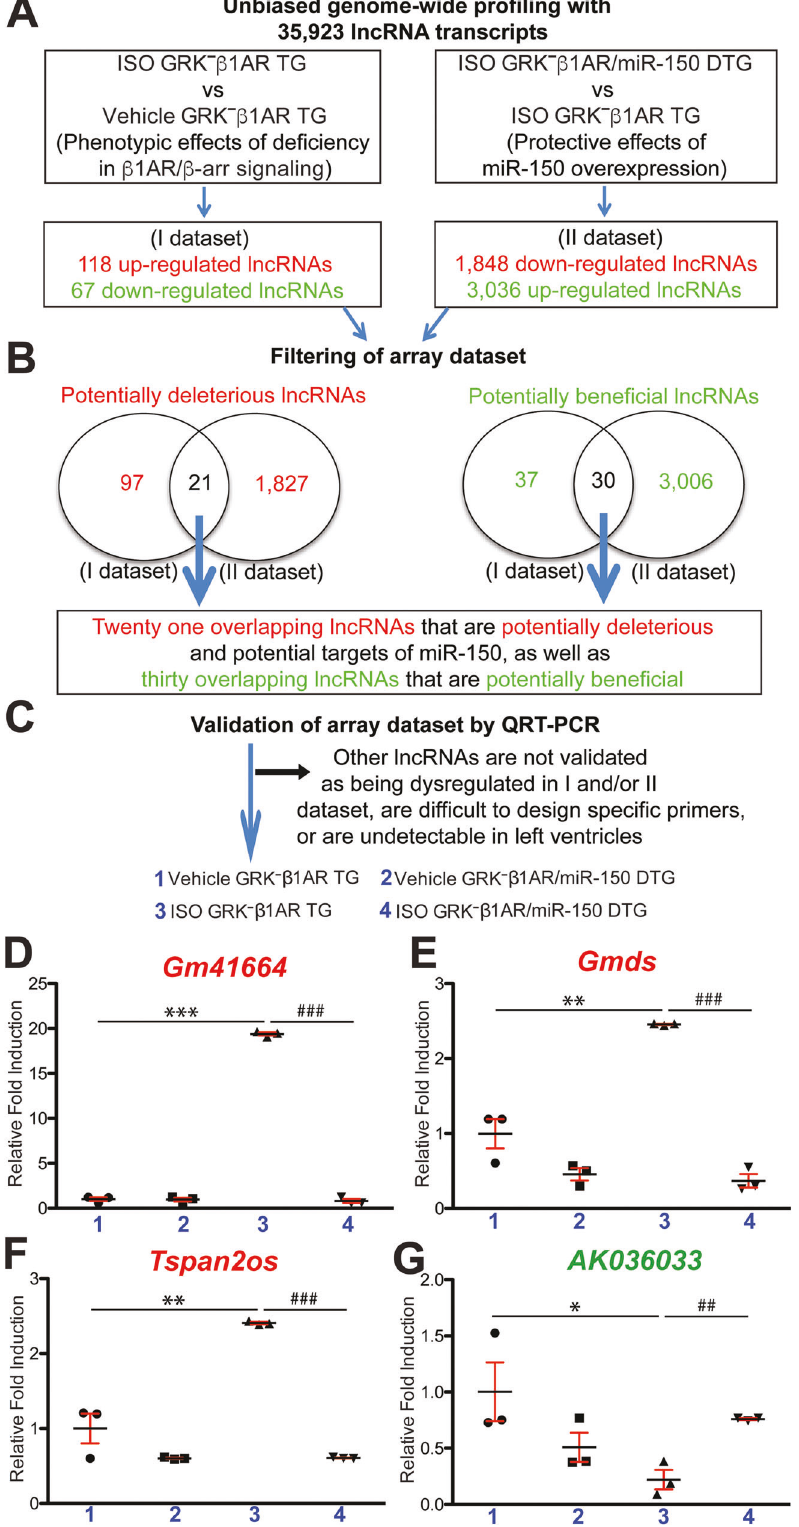
vehicle or ISO were investigated at 1-week post-treatment. We provide further details in Supplementary Results to describe Fig. S5, Fig. S6, Fig. S7, and Table S5. To de fi ne novel candidate targets that regulate miR-150 ’ s protective actions in mice with